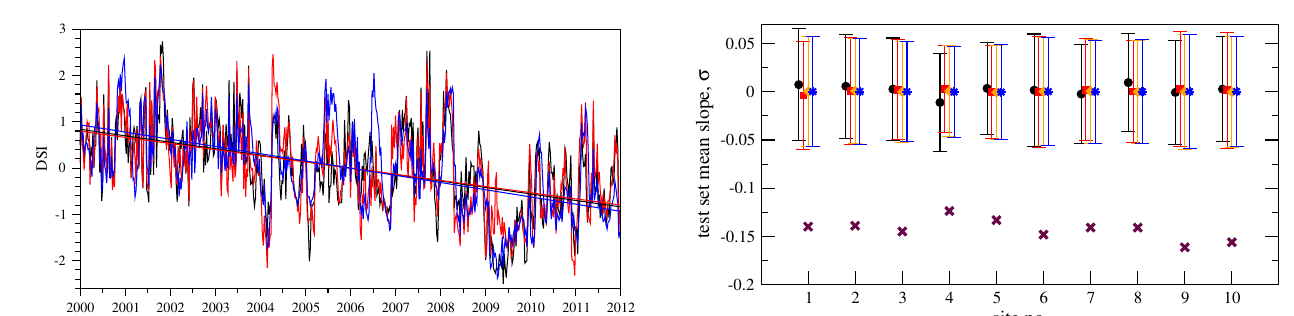
Figure 2. Significance analysis of fitted slopes by using test sets of randomly shuffled whole year DSI records. The ensemble means and standard deviations are plotted for 10 sites along lat- itude 30.025 ◦ S, evenly spaced by 0.05 ◦ westward starting from 63.775 ◦ W. Test set sizes are 100 (black circles), 1000 (red squares), 10000 (orange diamonds), and 100000 (blue stars). Maroon crosses indicate fitted slopes (year − 1 ) for the original measured time series.